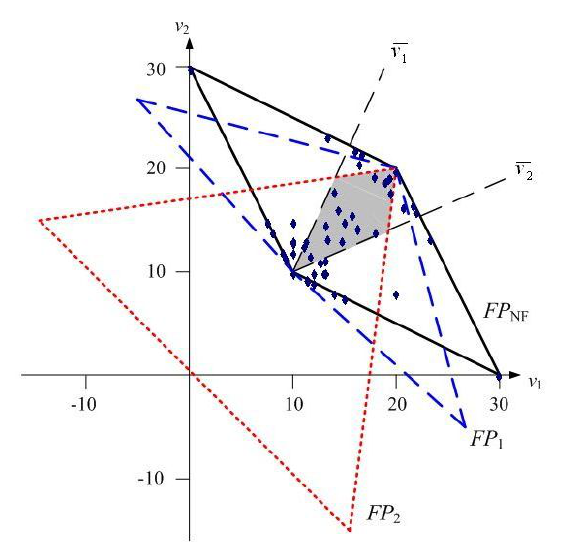
Figure 6. Comparison with observed